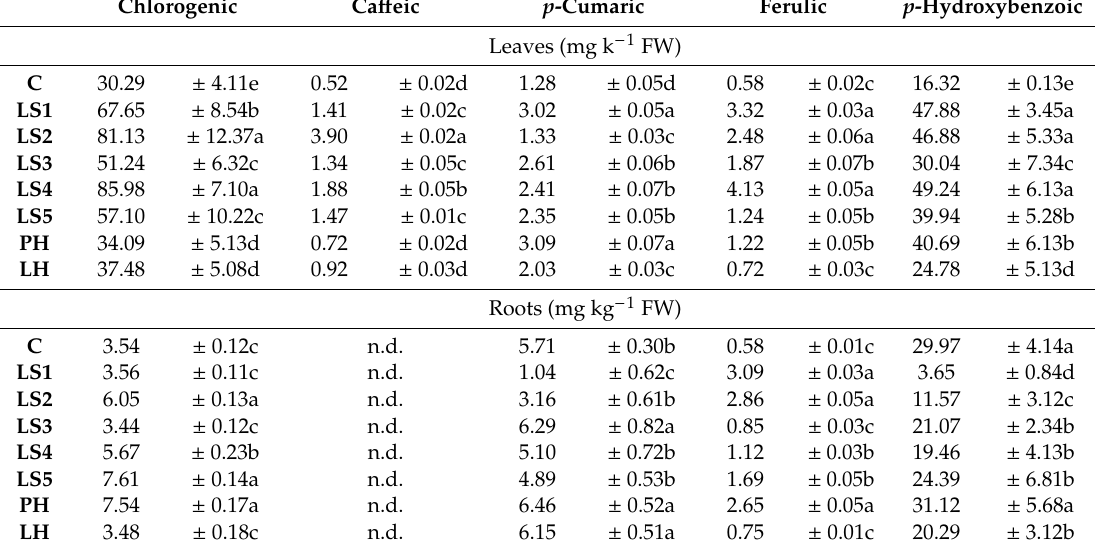
Table3. Profileofphenoliccompoundsinleavesandrootsof Z.mays L.Plantsweregrownfor12daysina nutrientsolutionandsuppliedwithindividualhumatesat1mgCL − 1 fortwodays. n.d. = notdetectable. Values along the same column following by di ff erent letters are statistically di ff erent at p < 0.05 ( n = 3, ± SD) according to Student–Newman–Keuls test. C = control; LH = commercial lignosulfonate-based product; PH = commercial humate extracted from leonardite; LS1 − LS5 = specialty